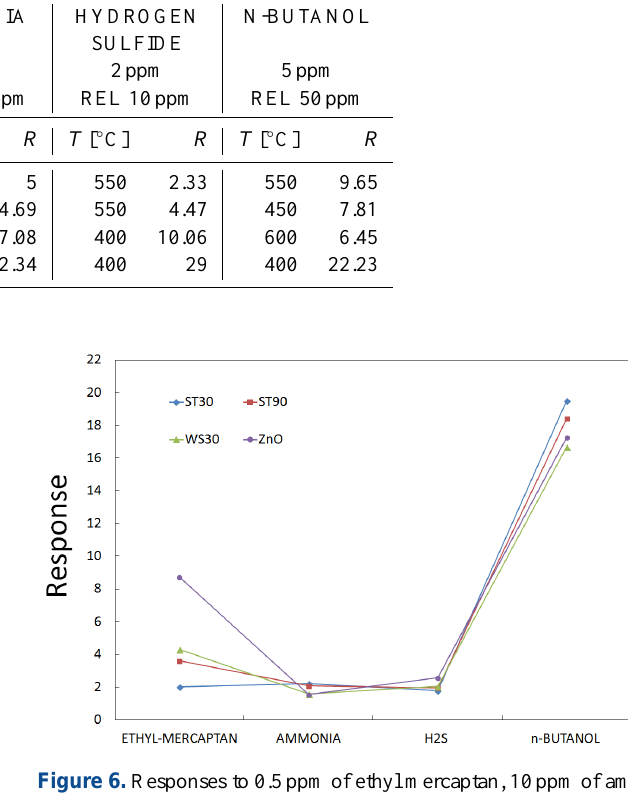
Figure 6. Responses to 0.5ppm of ethyl mercaptan, 10ppm of am- monia, 1ppm of hydrogen sulfide and 5ppm of n-butanol dispersed in a wet